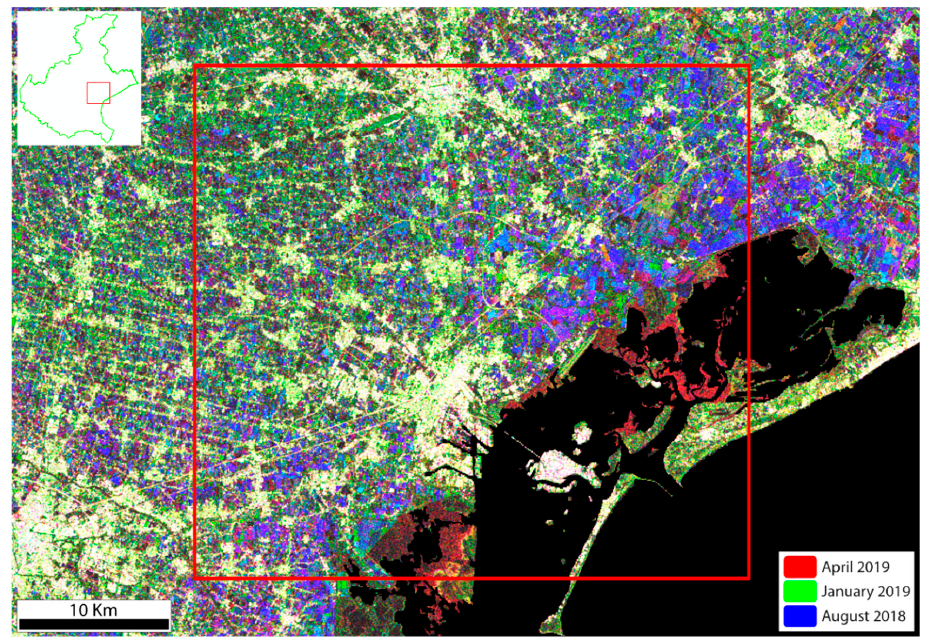
Figure 4. Raster image related to a stack of interferometric coherence images, produced from Sentinel- images from July 2018 to April 2019. In particular, this image displays in a band composition three coherence images from April 2019, January 2019, and August 2018, respectively, in the red, green, and blue channel. Urban areas are recognizable by their distinctively brighter color compared to all other land cover